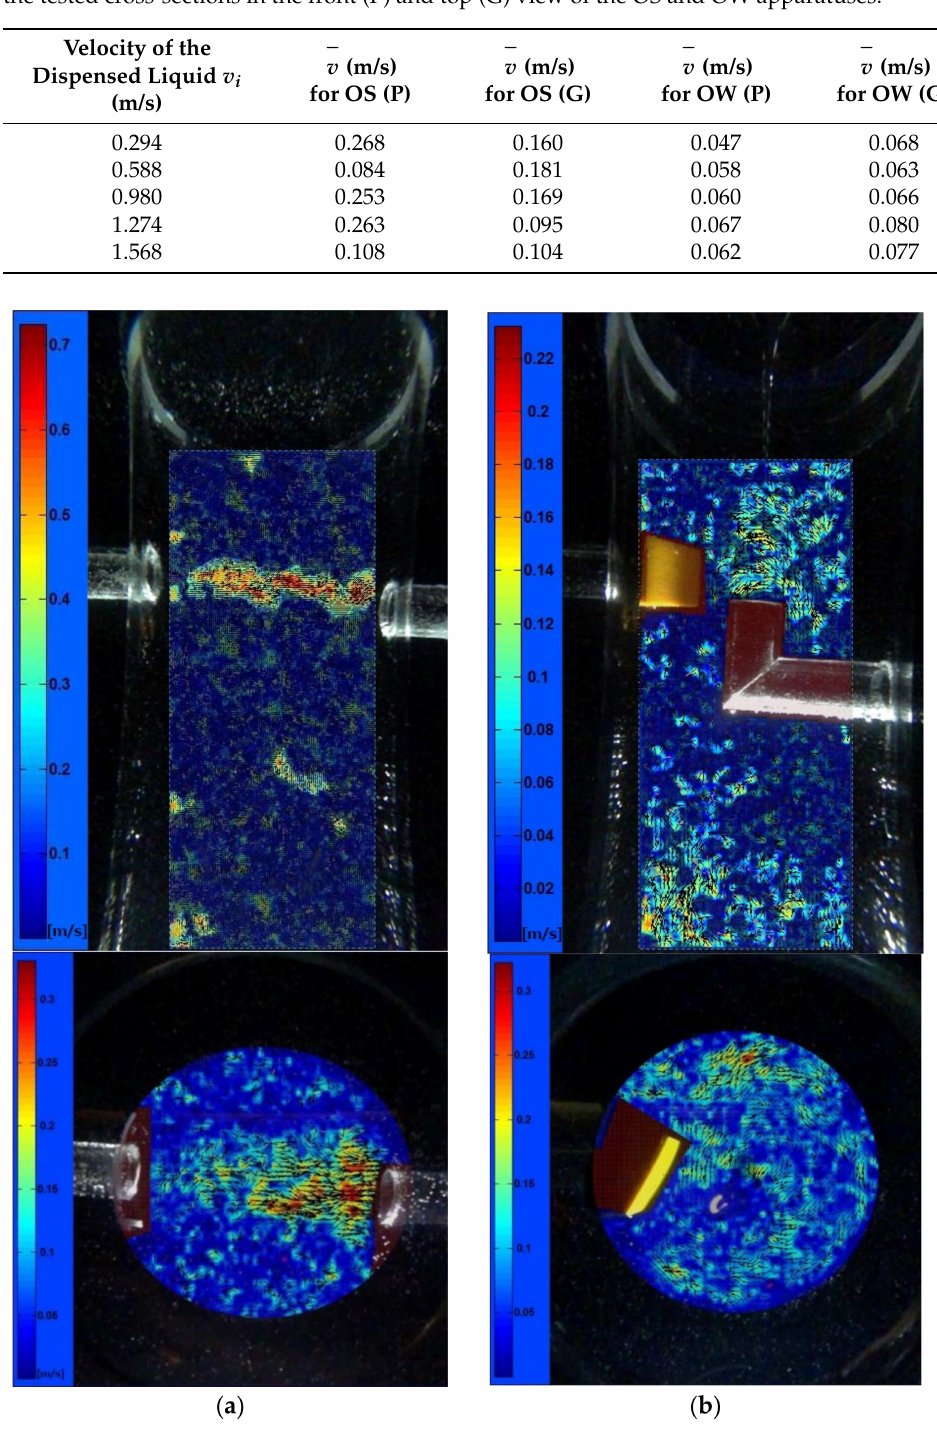
Figure 10. Velocity vector field maps for the tested sedimentation tank models in the case of velocity v 5 : ( a ) OS, ( b )